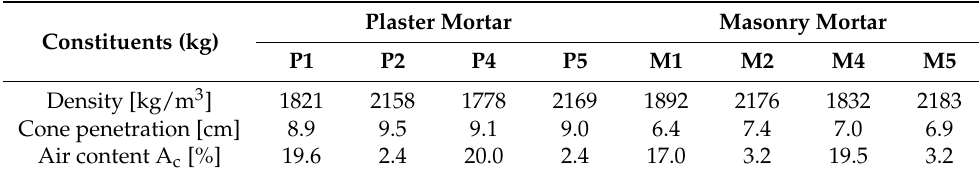
Table 4. Consistency and air content of the tested mortars.